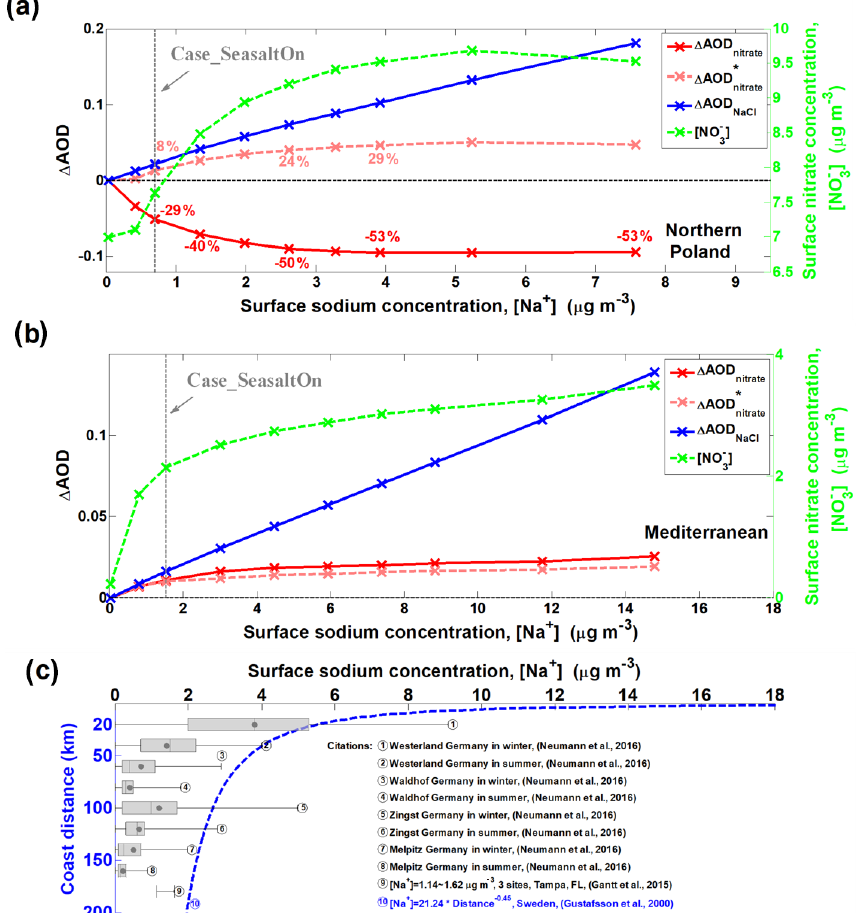
Figure 6. Sensitivity of aerosol optical depth ( (cid:49) AOD) as a function of sodium mass concentration ([Na + ]). Differences between Case_SeasaltOff and sensitivity cases (sea-salt emission with different scaling factors) for different aerosol components, i.e., nitrate ( (cid:49) AOD nitrate ) and sea salt ( (cid:49) AOD NaCl ): (cid:49) AOD (sensitivity case – Case_SeasaltOff) versus [Na + ] over northern Poland (a) and Mediter- ranean regions (b) , respectively. The model results shown here are averages over a sea-salt event during daytime (07:00–16:00LT) on 19 September 2013. The results of surface [NO − ] are indicated by the dashed green line. Here, the Case_SeasaltOff is the reference case and 3 Case_SeasaltOn is marked. Note: (cid:49) AOD ∗ (dashed pink line) indicates the (cid:49) AOD of nitrate calculated by reallocating nitrate mass into nitrate different size bins according to the normalized nitrate particle mass size distribution simulated in Case_SeasaltOff (i.e., without redistribution effect). (c) The measured [Na + ] at different sites over Sweden as a function of coast distance, as well as in Germany (marked in Fig. 3) and the US. The box-and-whisker plots of the references marked (1)–(8) indicate the median, mean (black dot), 25th percentile, 75th percentile, maximum and minimum. The error bar of reference no. (9) indicates the range. The dashed blue line of reference no. (10) indicates the statistically empirical function of [Na + ] with distance from coast, based on the network measurements of 16 sites in